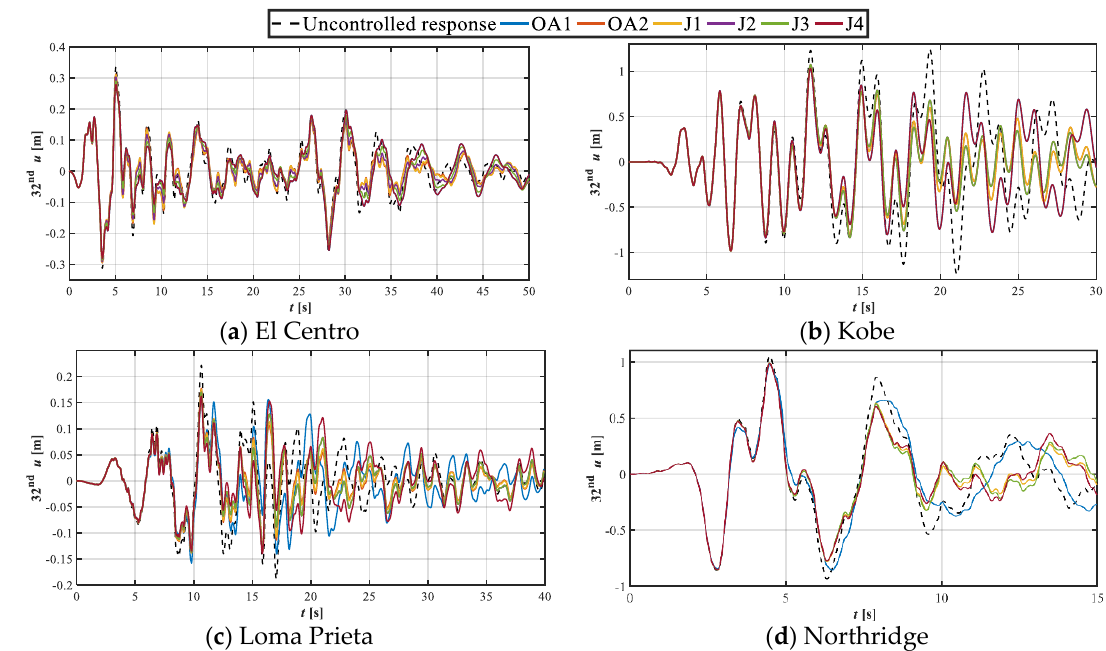
Figure 5. Displacement of the 32nd story of the structure equipped with TMDs with μ = 0.02.